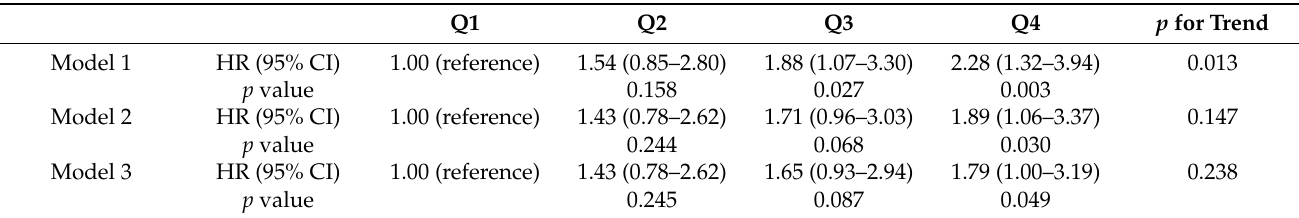
Table 5. Hazard ratios and 95% confidence intervals for new-onset ischemic heart disease (IHD) according to atherogenic index of plasma (AIP) quartiles only in the male population.